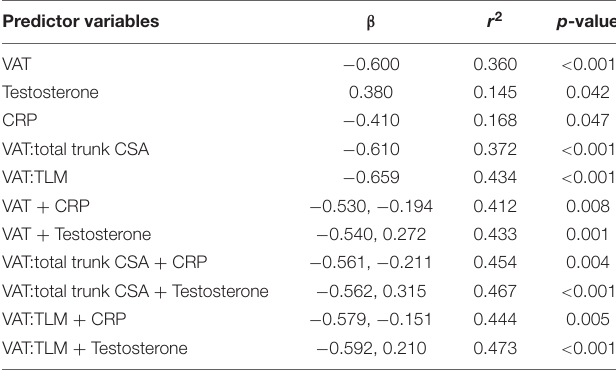
TABLE 3 | Single and multiple regressions predicting citrate synthase